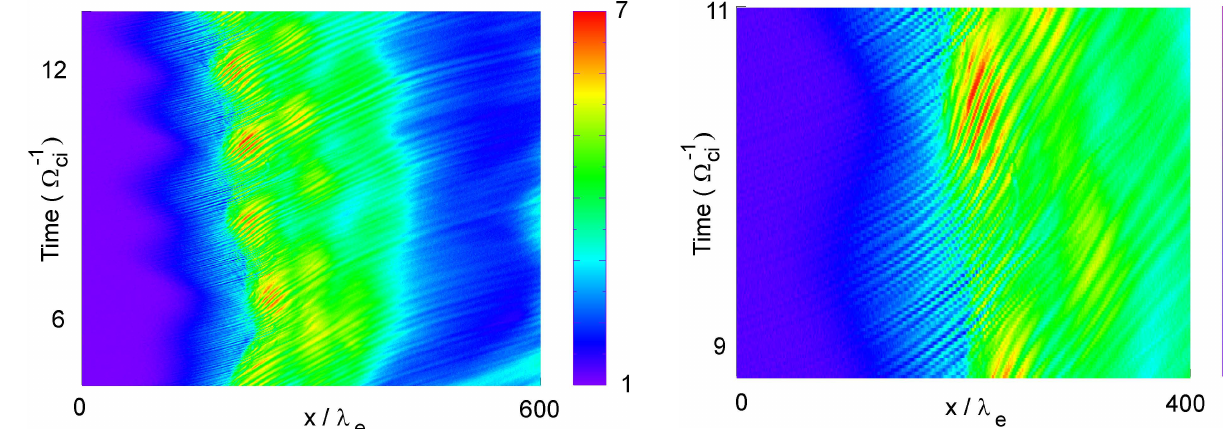
Fig. 2. Same as Figure 1 for a smaller time period.